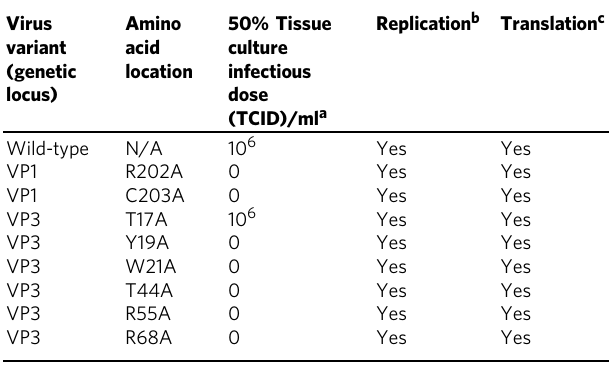
Table 3 Capsid proteins VP1 and VP3 alanine mutants tested in cell culture and in vitro Virus variant (genetic locus)